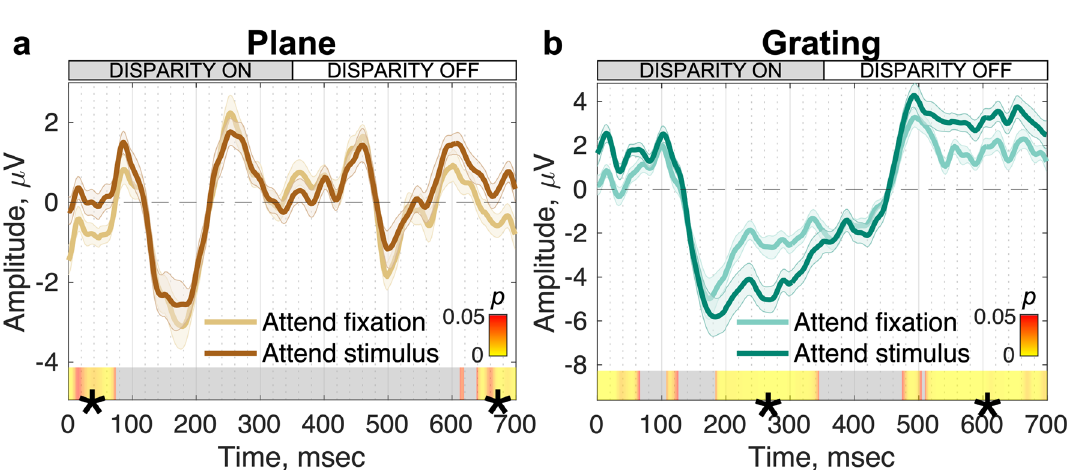
Figure 4. EEG responses to plane and grating disparity stimuli under different task demands (N = 20). ( a ) Responses to the plane (pure absolute disparity) stimulus. Responses during attend fixation (light brown) and attend stimulus (dark brown) conditions are highly similar and transient waveforms are observed at both disparity on and disparity off stimulus transitions. ( b ) Responses to the grating (relative and local absolute disparity) stimulus. Responses during the attend fixation (light green) and attend stimulus (dark green) are initially similar up to ~ 184 ms when they begin to diverge. For both panels, data are the group mean waveform in RC1, and errors are ± 1 SEM. Data have been filtered using the nF1 clean filter. Heat bars indicate significance (paired-samples t -test) and segments marked with (*) indicate sequential, significant time points that pass the threshold for run-length correction and grey =